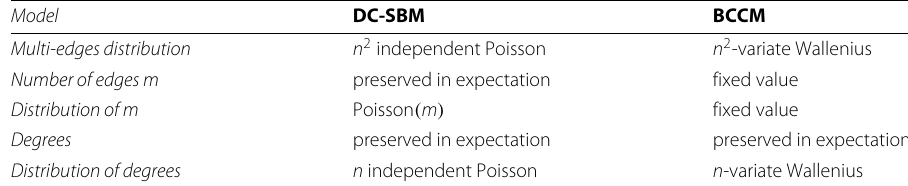
Table 1 Comparison of the properties of DC-SBMs and BCCMs